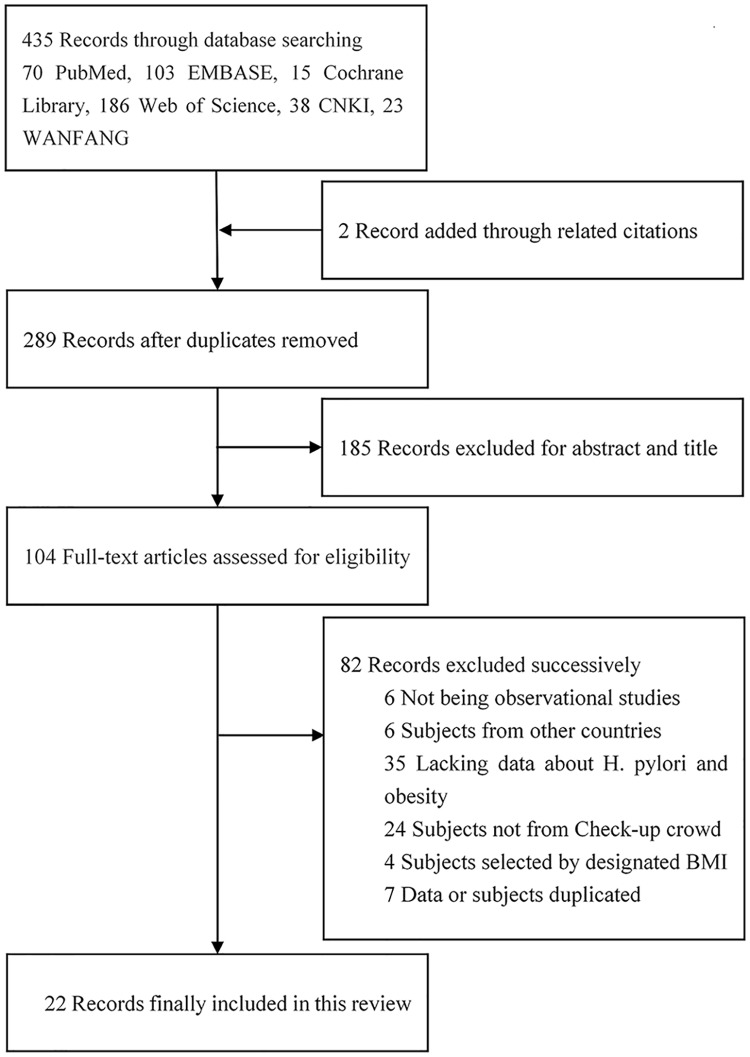
Literature retrieval flow chart.